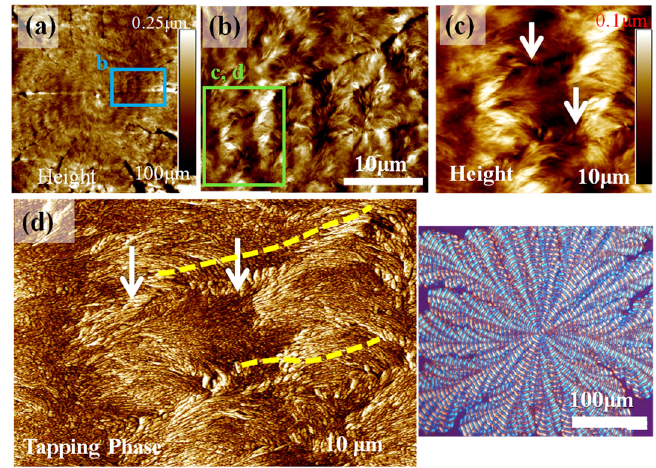
Figure 6. AFM height/phase images with stepwise zoom-in: ( a ) top surface of dendrite-ringed PPDO spherulite crystallized from PPDO/PVPh (75/25) at T c = 78 °C, and ( b ) zoom-in revealing the microscopic branching pattern of the zoom-in to square-marked zone in graph ( a ), and ( c ) AFM height and ( d ) AFM phase images of bands in individual branches. (Inset: POM micrograph on lower right).